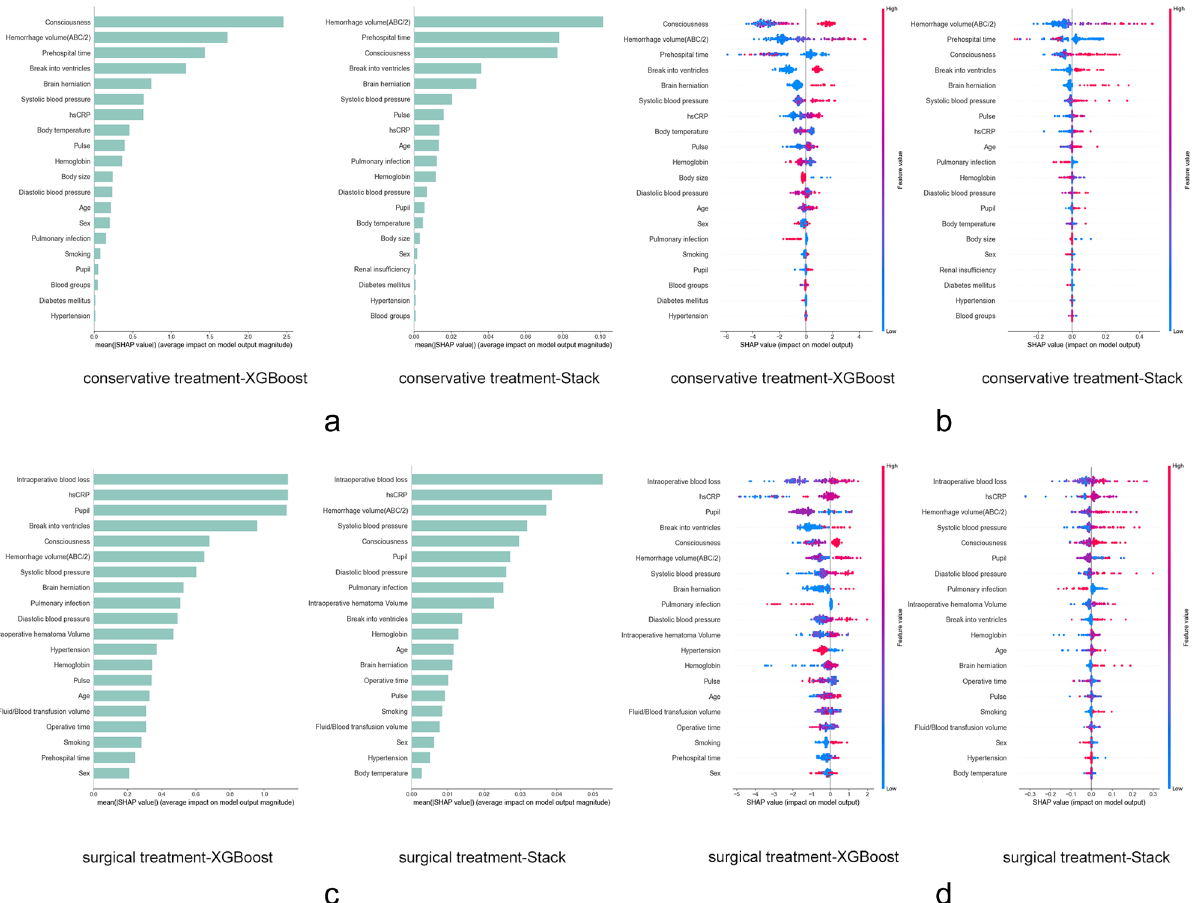
Figure 5. Overall SHAP interpretation of XGBoost and Stack model risk stratification. XGBoost uses the tree model interpretation method and the Stack model uses the Kernel interpretation method. ( a , c ): Ranking of all features in order of importance and showing the top 20 features. ( b , d ): Distribution showing the correlation of features with risk stratification results. Each point is a sample, red dots represent a high value of features, blue dots represent a low value of features, a negative SHAP value indicates a decrease in the probability of high risk and a positive one indicates an increase in the probability of high